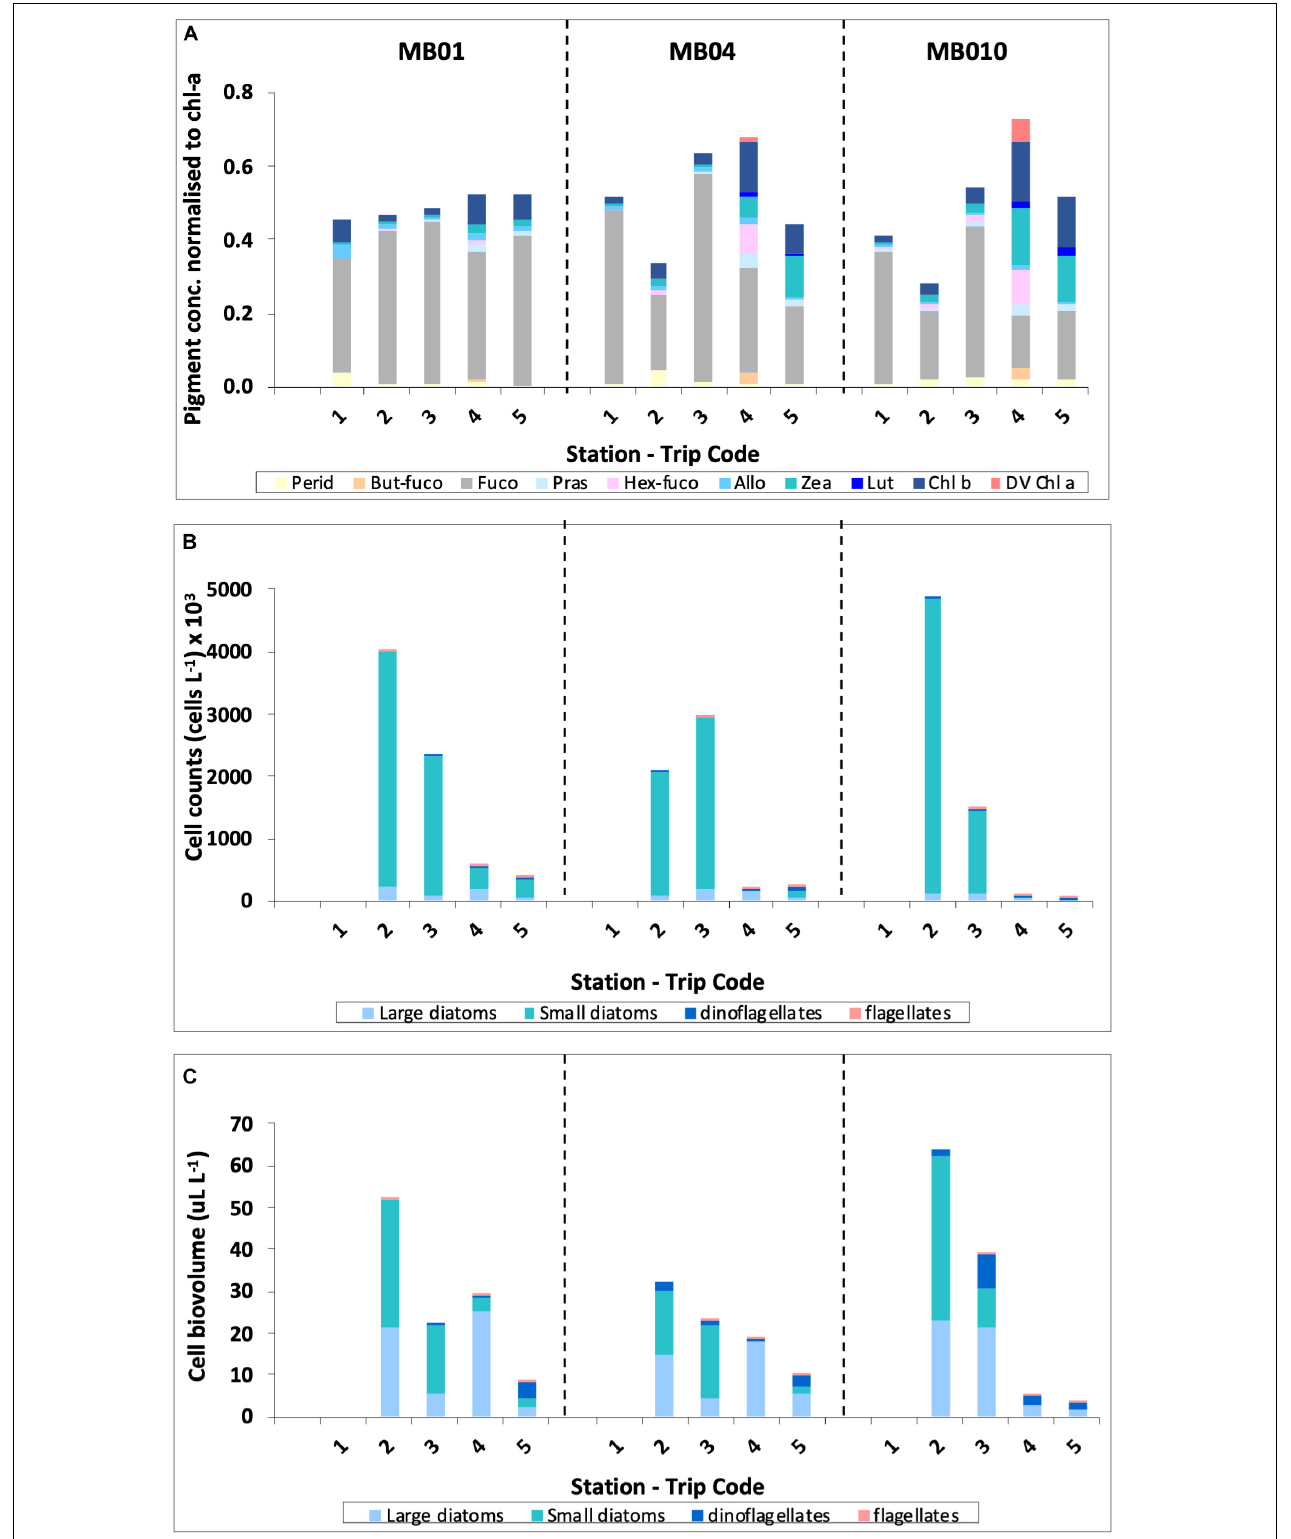
FIGURE 6 | Phytoplankton composition in the surface waters of Moreton Bay during the five sampling trips post flood as indicated by: (A) pigment composition, (B) Phytoplankton cell counts, and (C) Phytoplankton cell counts adjusted for biovolume.